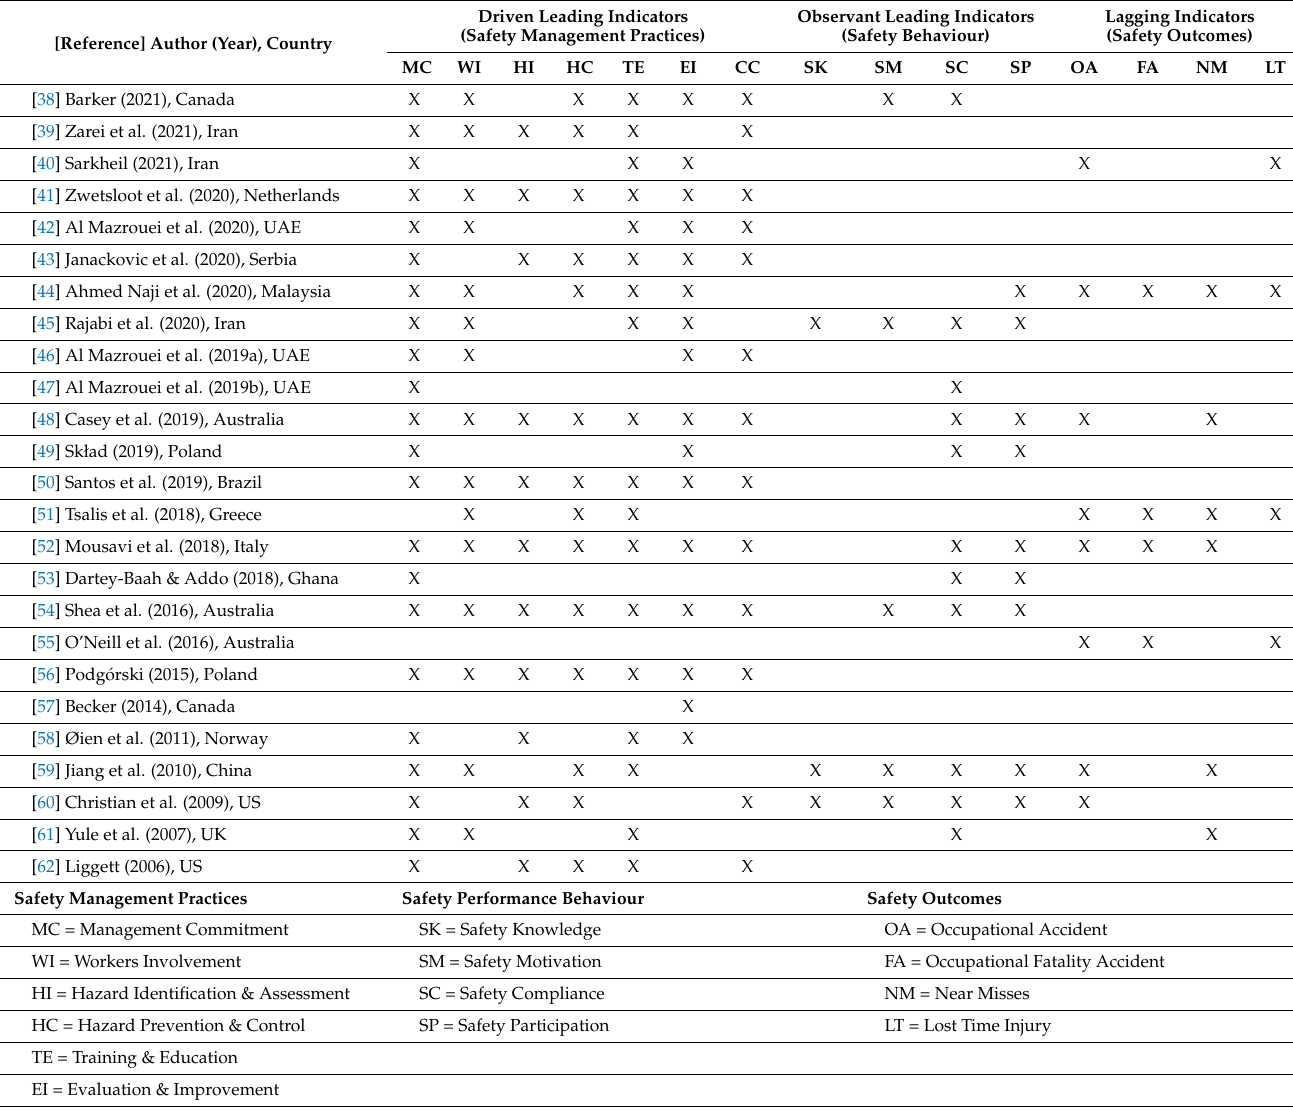
Table 3. The groups and